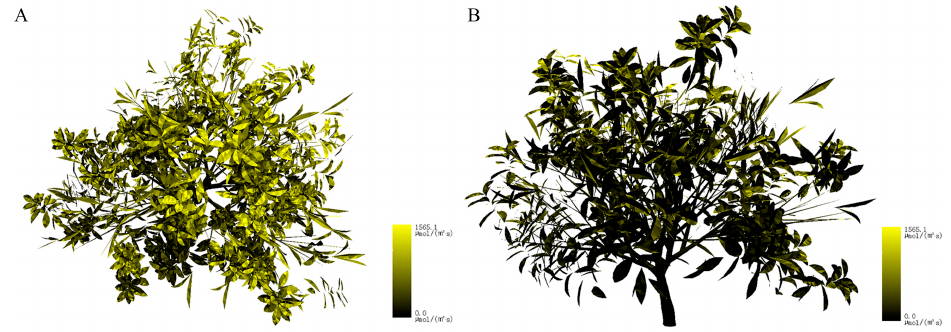
Figure 7. Direct solar PAR distribution within the virtual loquat canopy at 12:00 on June 21, 2016. The brightness corresponds to the irradiation intensity. ( A ) Overhead view and ( B ) profile view. Table 2 shows the parameters obtained from the simulated results of the two methods. The amount of PAR captured within the canopy as determined by the ray tracing is approximately 6.7% lower than the value based on the hourly radiosity.